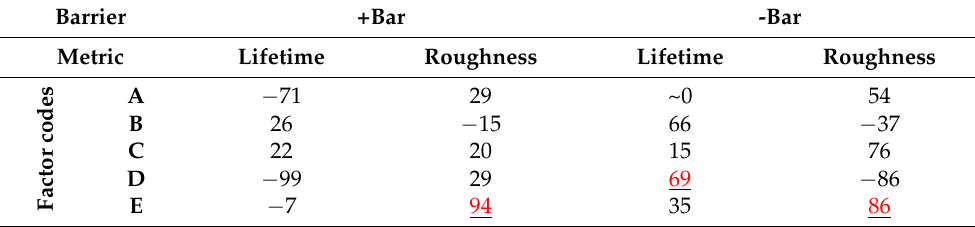
Table 4. R 2 (%) for the response variables per each factor. See Table 1 for the references to the adj factor codes. Barrier +Bar -Bar Metric